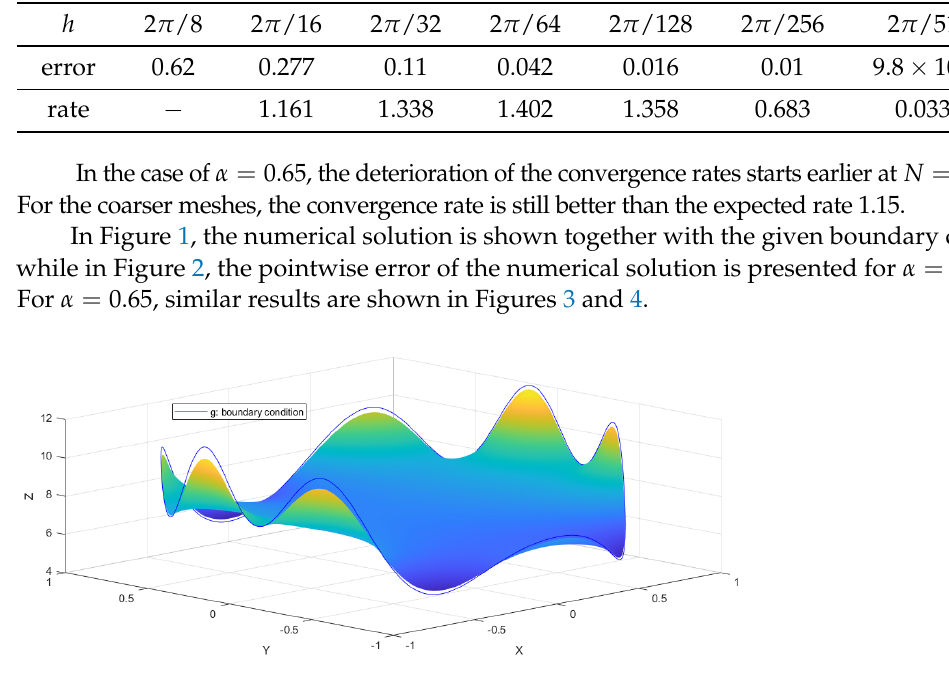
Figure 1. Boundary condition and numerical solution ˜ u h of (21) for α = 0.75 and N = 512 inside the domain.